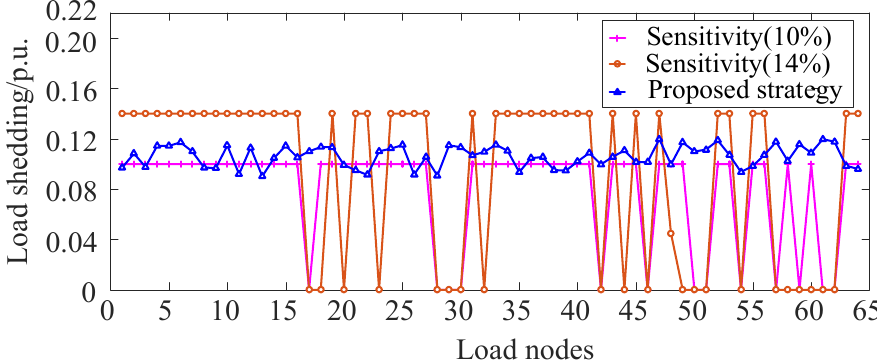
Figure 9. Load shedding amount under different schemes.